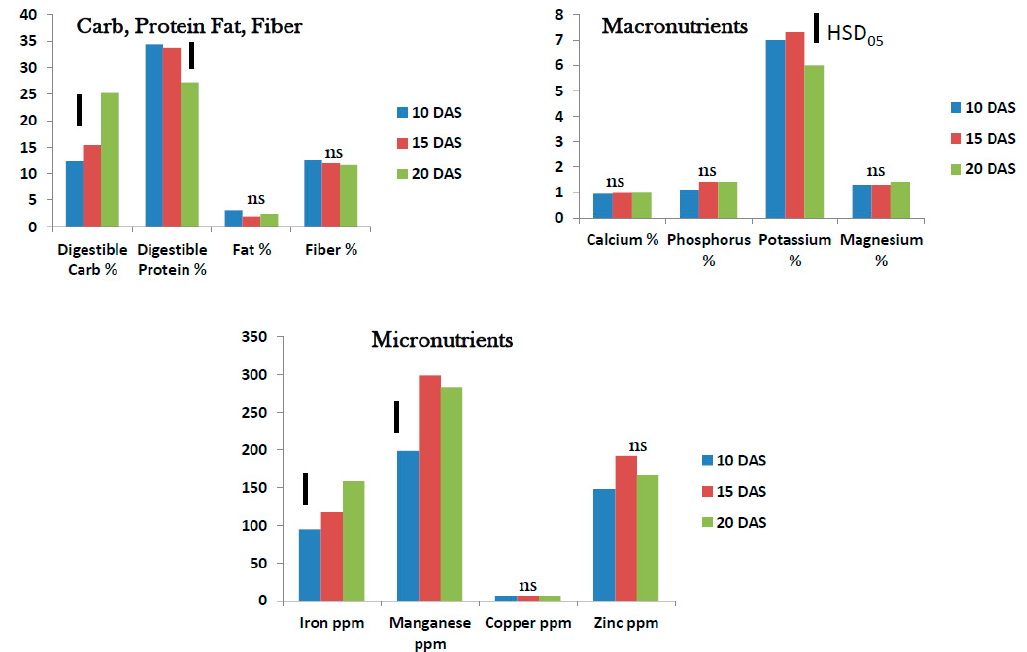
Figure 2. Tropical spinach micro/baby-green: nutrient status (dry weight basis) 10–20 days after seeding (DAS) (ns = no significant difference; bars show Tukey’s HSD at α = 0.05).